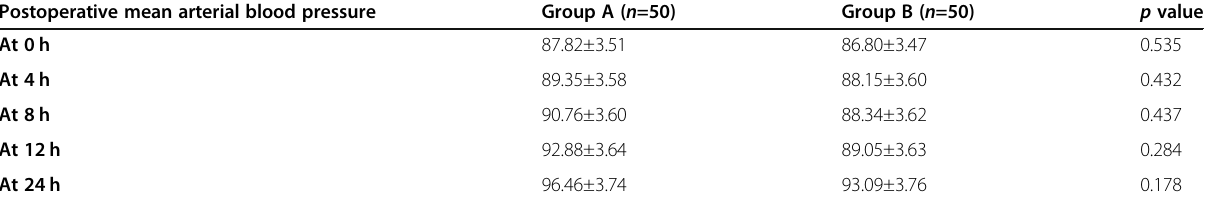
Table 2 Difference between group A and group B according to postoperative mean arterial blood pressure (mmHg)